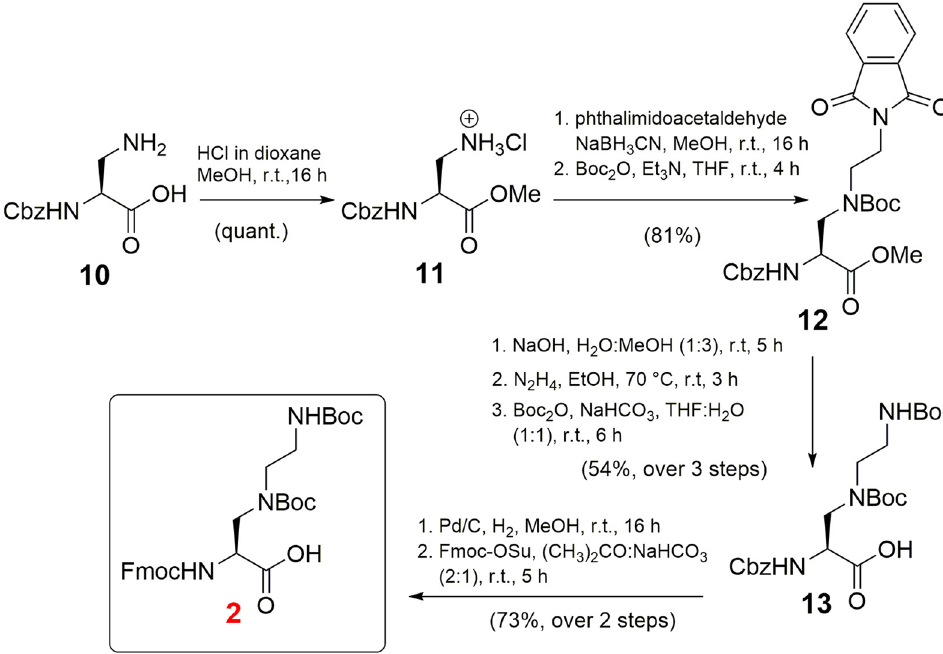
Figure 3. Synthesis of Fmoc-Kn(Boc) 2 -OH ( 2 ).